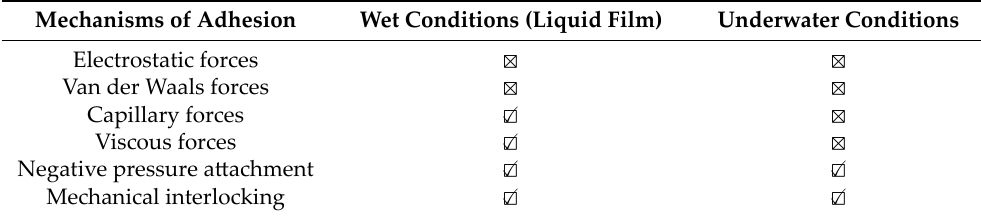
Table 1. Effective attachment mechanism under wet and immersion conditions